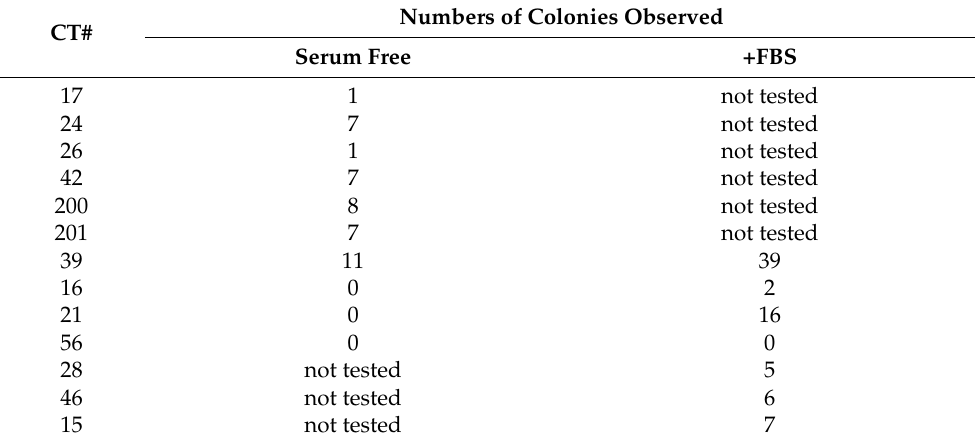
Table 1. Culture conditions used to grow the CT-MSCs prior to reprogramming and reprogram- ming